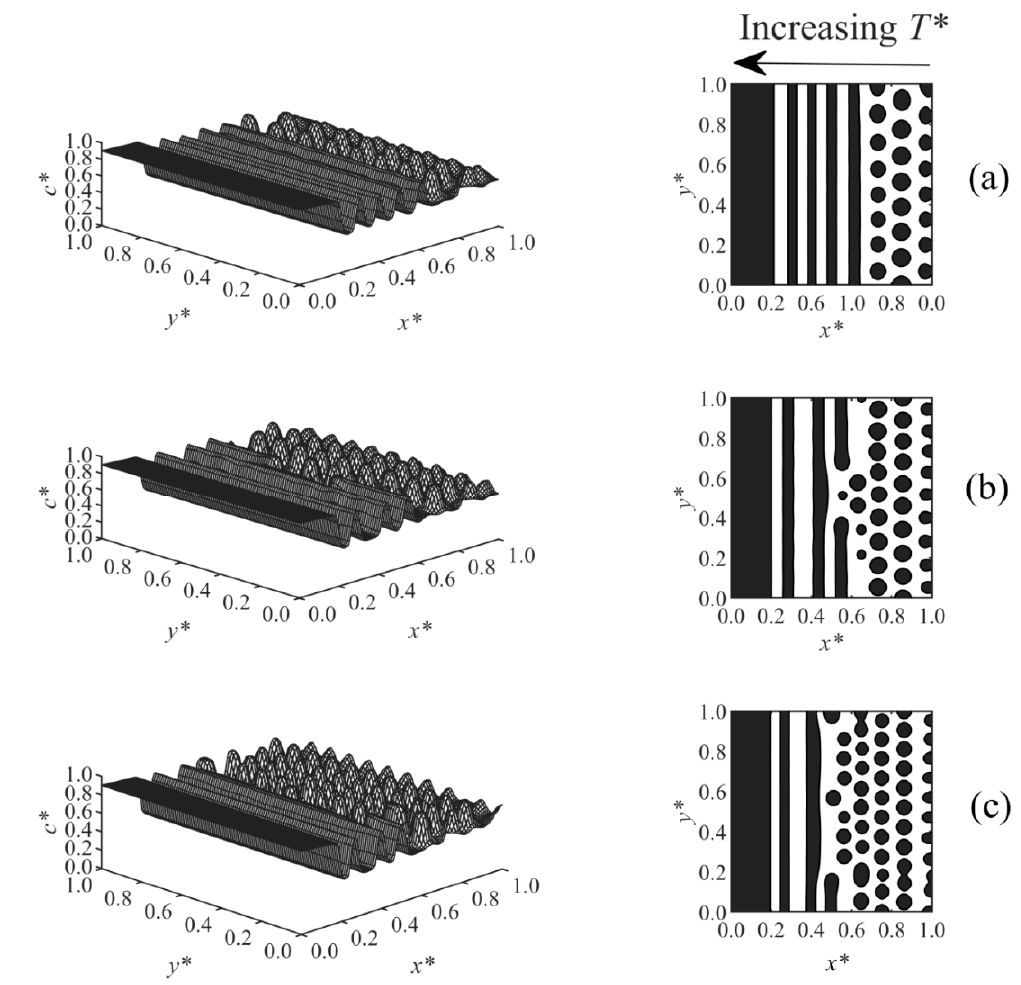
Figure 7. Spatial concentration distributions (first column) and phase-separated morphologies (second column) for Case 5 at the following dimensionless times and diffusion coefficients: ( a ) t * = 5.6 × 10 − 5 , D = 6 × 10 5 , ( b ) t * = 5.55 × 10 − 5 , D = 8 × 10 5 , and ( c ) t * = 5.525 × 10 − 5 , D = 1 × 10 6 .